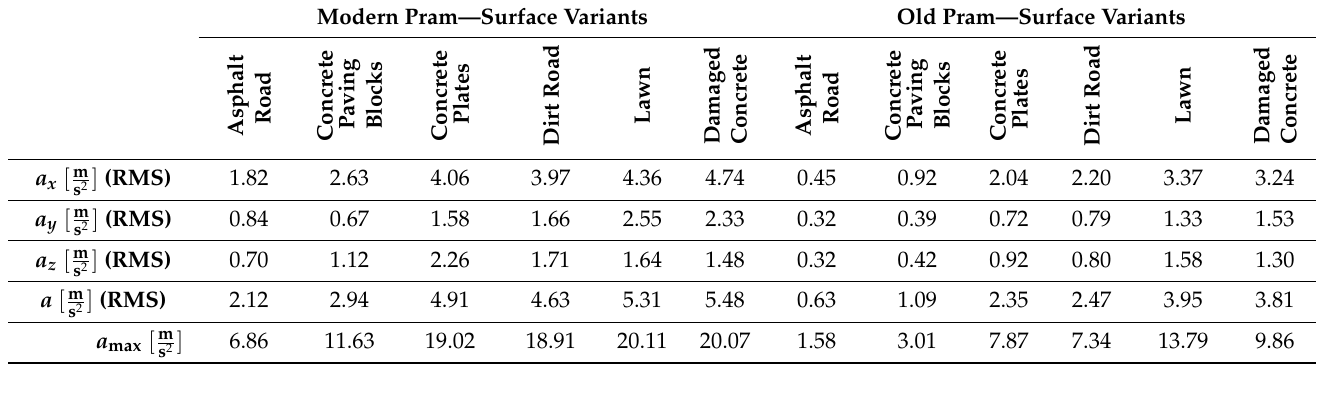
Table 2. RMS and maximum acceleration values (static acceleration component excluded) applied to the weight placed in the space provided for a child in the tested perambulators.